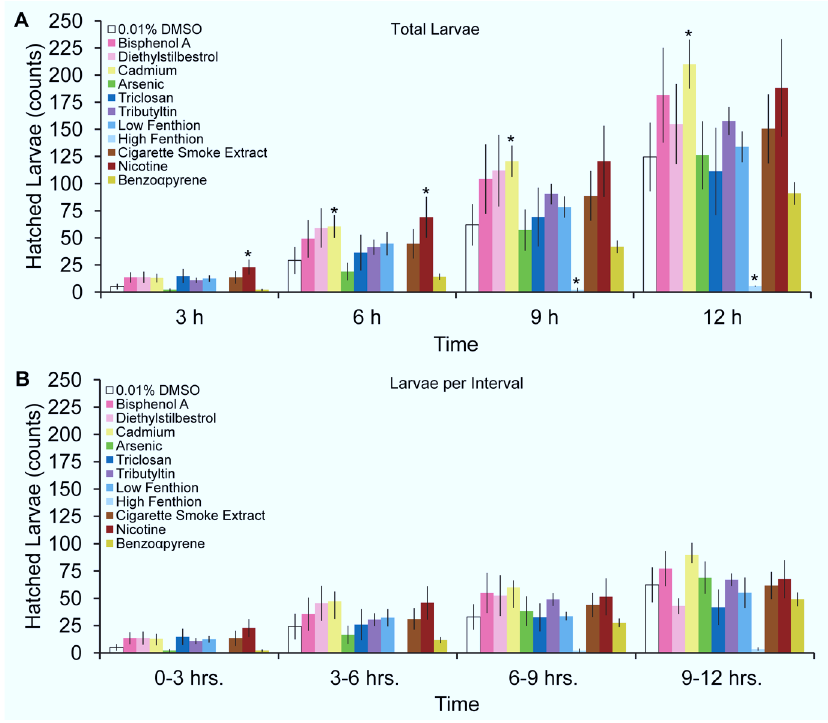
Figure 4. Effects of teratogens on hatched larvae. Temporal pattern of ( A ) cumulative hatched larvae from eggs laid at 3, 6, 9 and 12 hours post-exposure to teratogens and ( B ) number of hatched larvae per teratogen group or control in 3 hours intervals (mean ± sem). Asterisks indicate P <0.05.